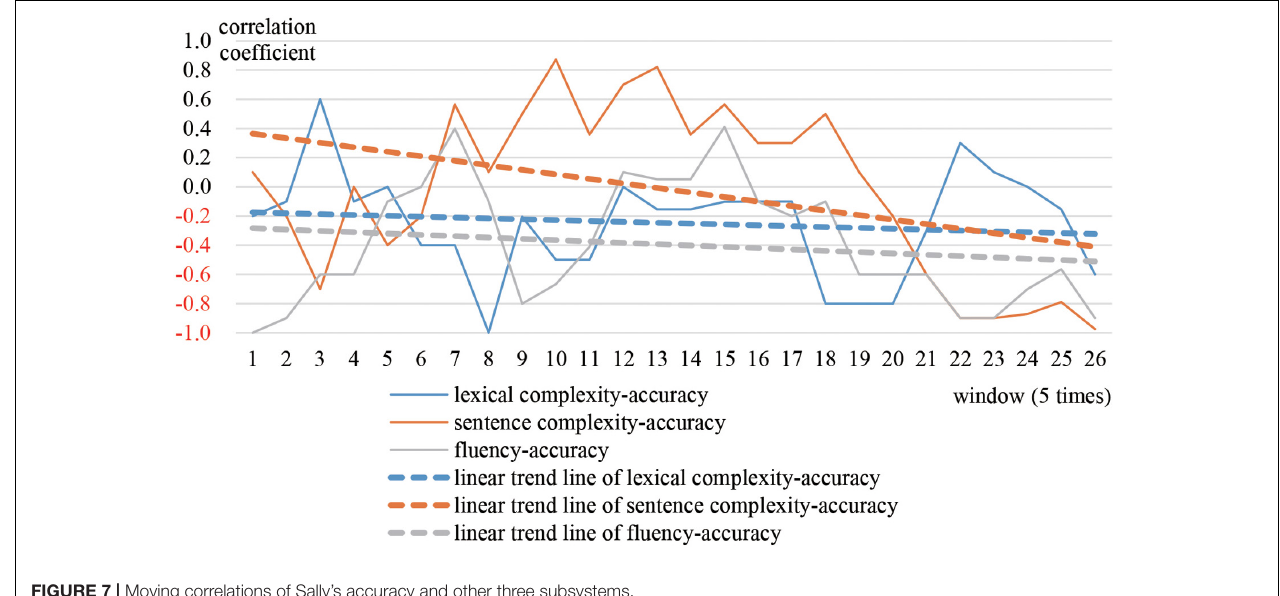
FIGURE 7 | Moving correlations of Sally’s accuracy and other three subsystems.